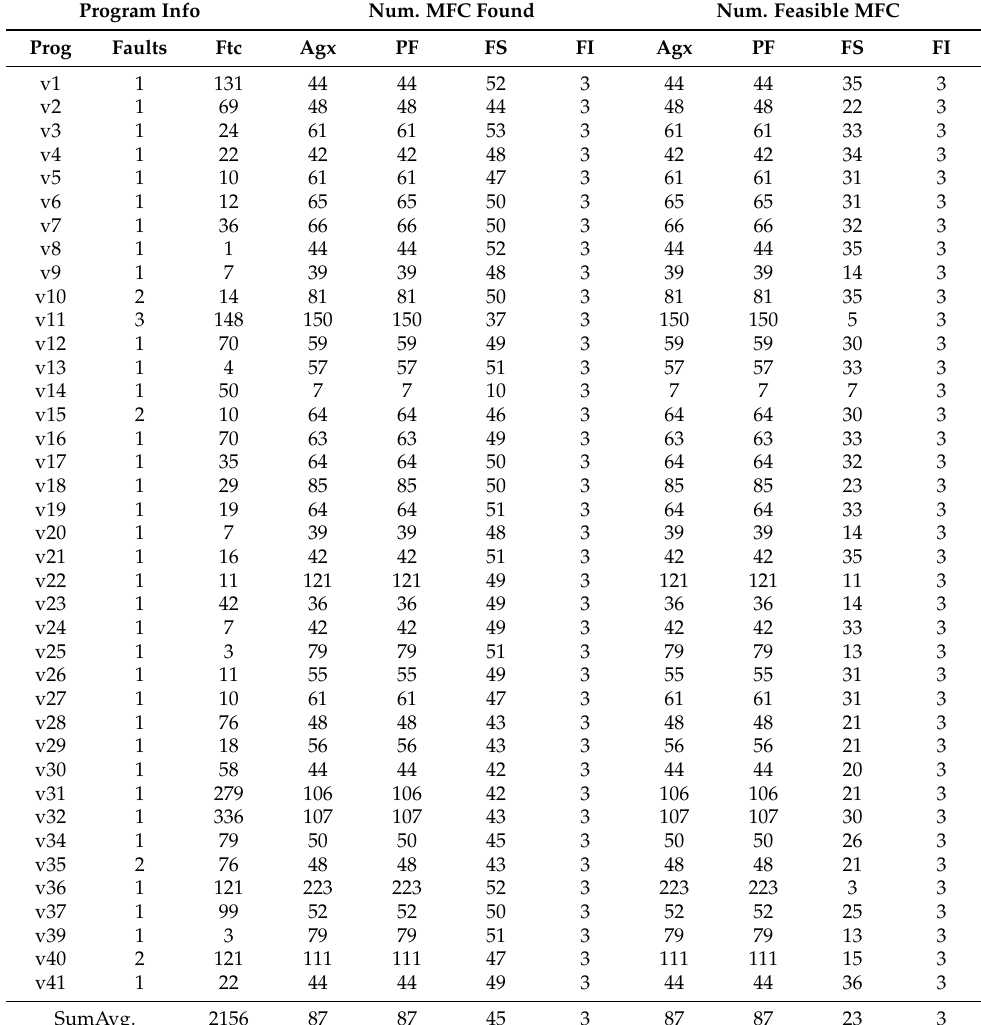
Table 1. Comparison of the effectiveness in finding minimal angelic fix candidate of AgxFaults (Agx), Program Formula (PF), Single Path Control-Flow Sensitive (FS), and Control-Flow Insensitive (FI) approaches on the traffic collision avoidance system (TCAS)